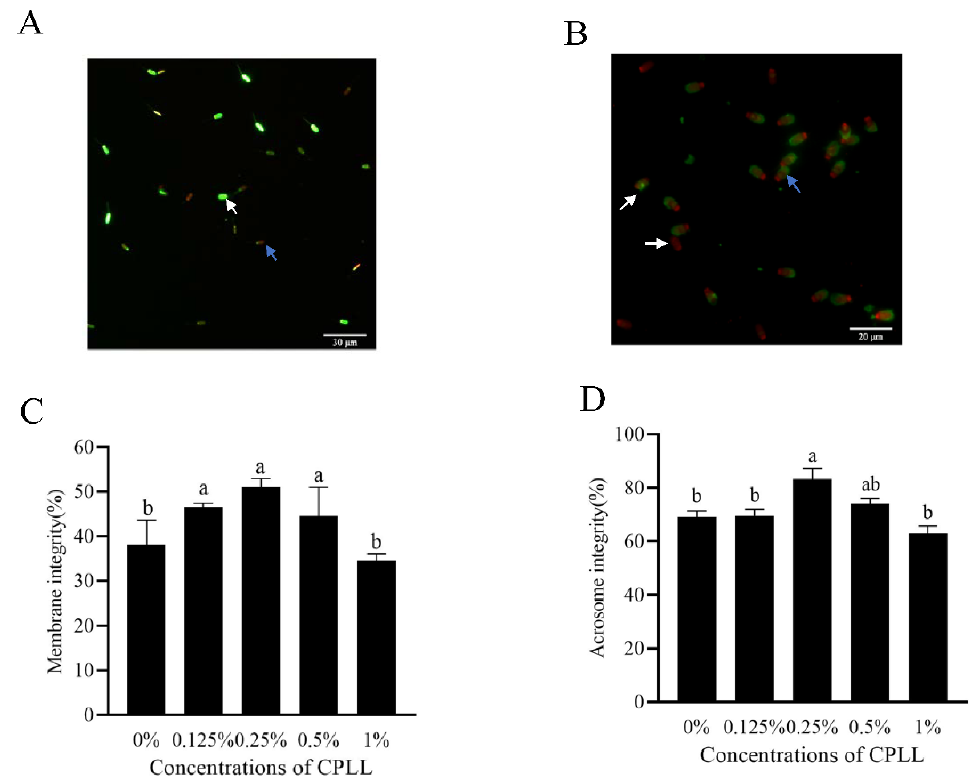
Figure 1. Photos of the post-thaw boar sperm stained with LIVE/DEAD sperm viability kit ( A ) and fluorescein isothiocyanate-peanut agglutinin ( B ) working solution, respectively. In image ( A ), the white arrow presented the post-thaw sperm with membrane integrity while the blue arrow presented post-thaw sperm with damaged integrity. In image ( B ), the white arrow indicated the post-thaw sperm with damaged acrosome, whereas the blue arrow indicated the post-thaw sperm with intact acrosome. Effects of supplementation with different concentrations of CPLL to the freezing medium on post-thaw boar sperm membrane integrity ( C ) and acrosome integrity ( D ). Values are specified as mean ± standard error of the mean (SEM). Columns with different lowercase letters differ significantly ( p < 0.05), n = 5.